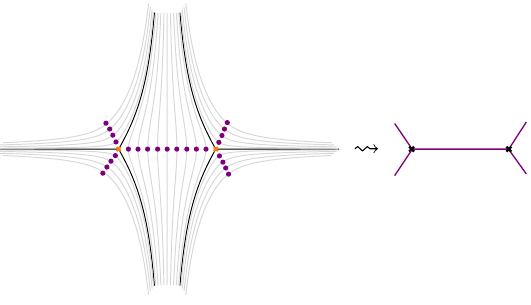
Figure 12 . Left: a portion of the foliation on C . One point on each leaf is marked. Right: the corresponding portion of the leaf space, which is a trivalent tree.